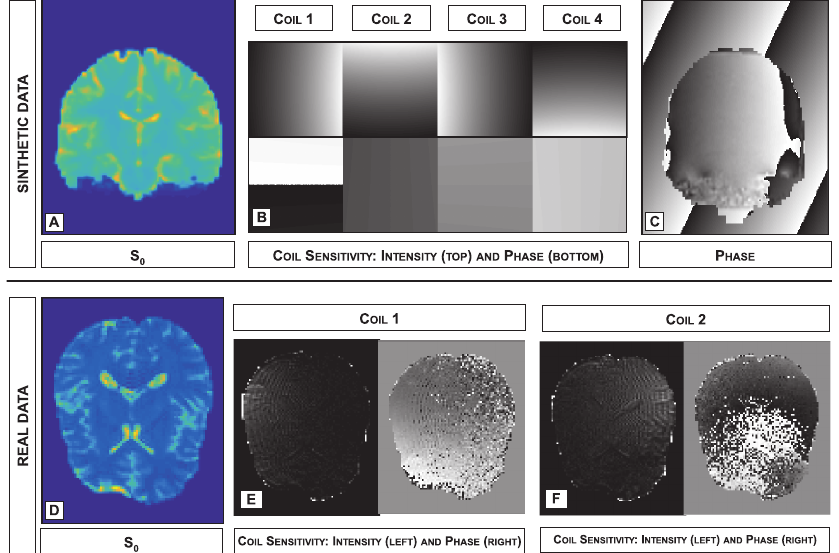
Figure 3. First row: s 0 image ( A ) and coil sensitivity maps (magnitude ( top B ) and phase ( bottom B )) used in the experiments performed with synthetic data. ( C ) Example of phase map estimated with synthetic data when considering motion and magnetic field inhomogeneities. Second row: s 0 image ( D ) and magnitude and phase estimated for two different coils ( E , F ) for the experiments performed with real